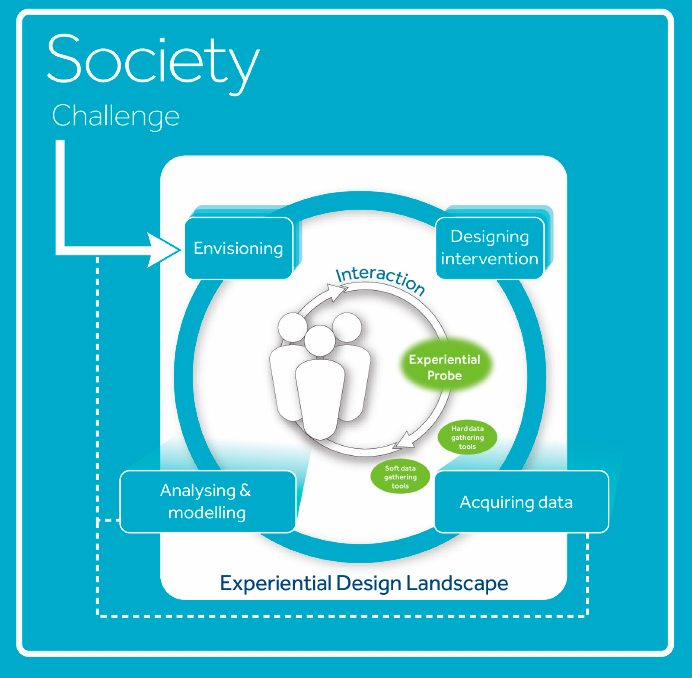
Figure 2. A schematic overview of the Experiential Design Landscapes (EDL) method, showing the cyclic nature of the method.